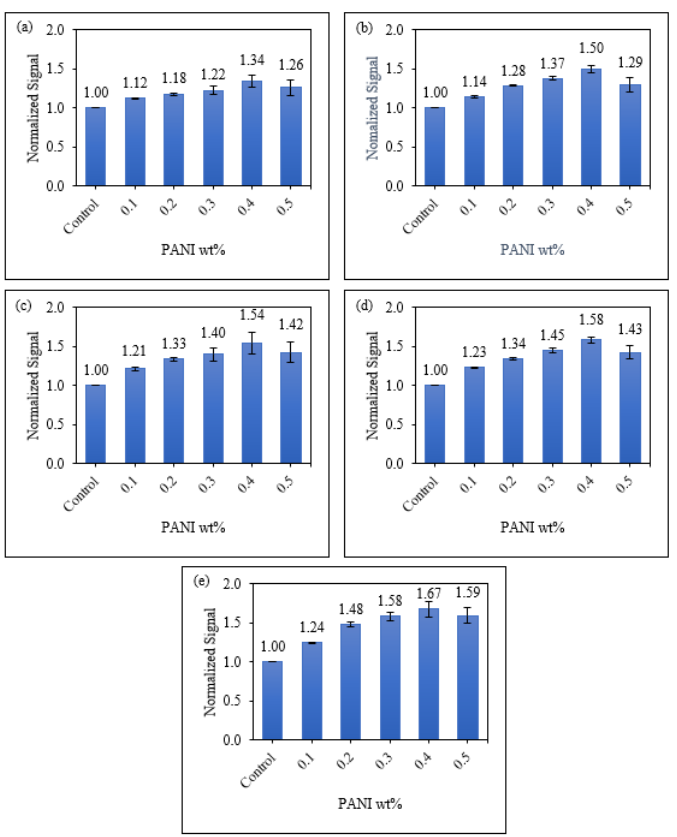
Figure 10. The normalised change of colour signal of control and starch/PANI (0.1%, 0.2%, 0.3%, 0.4%, 0.5%) films against ( a ) 200 ppm; ( b ) 400 ppm; ( c ) 600 ppm; ( d ) 800 ppm; ( e ) 1000 ppm ammonia solution.